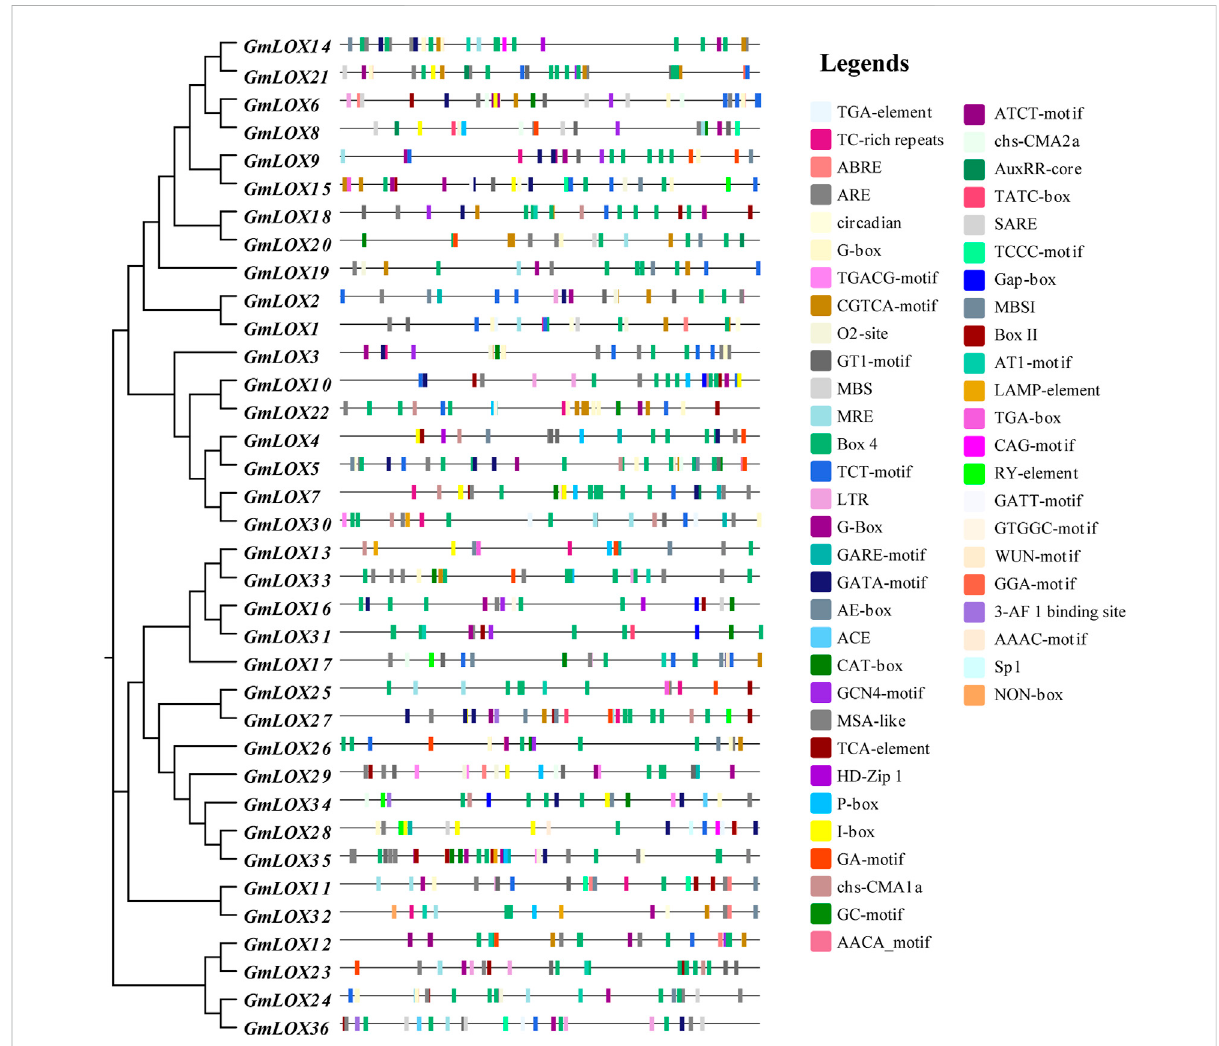
FIGURE 7 Analysis of cis-elements in the promoters of GmLOX genes Note: 2,000 bp upstream from the transcription initiation site was intercepted for analysis, and the sequence lengths in the fi gure all represent 2000. Response elements involve stress, growth and development, hormones, light response and so